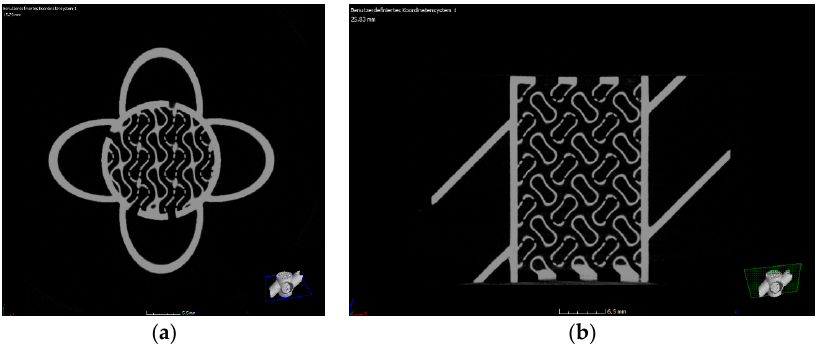
Figure 10. Cross-section images recalculated from the computed tomography (CT) scan of the sintered alumina reactor component (outer diameter of reactor: 12 mm): horizontal cross-section ( a ), vertical cross-section ( b ).